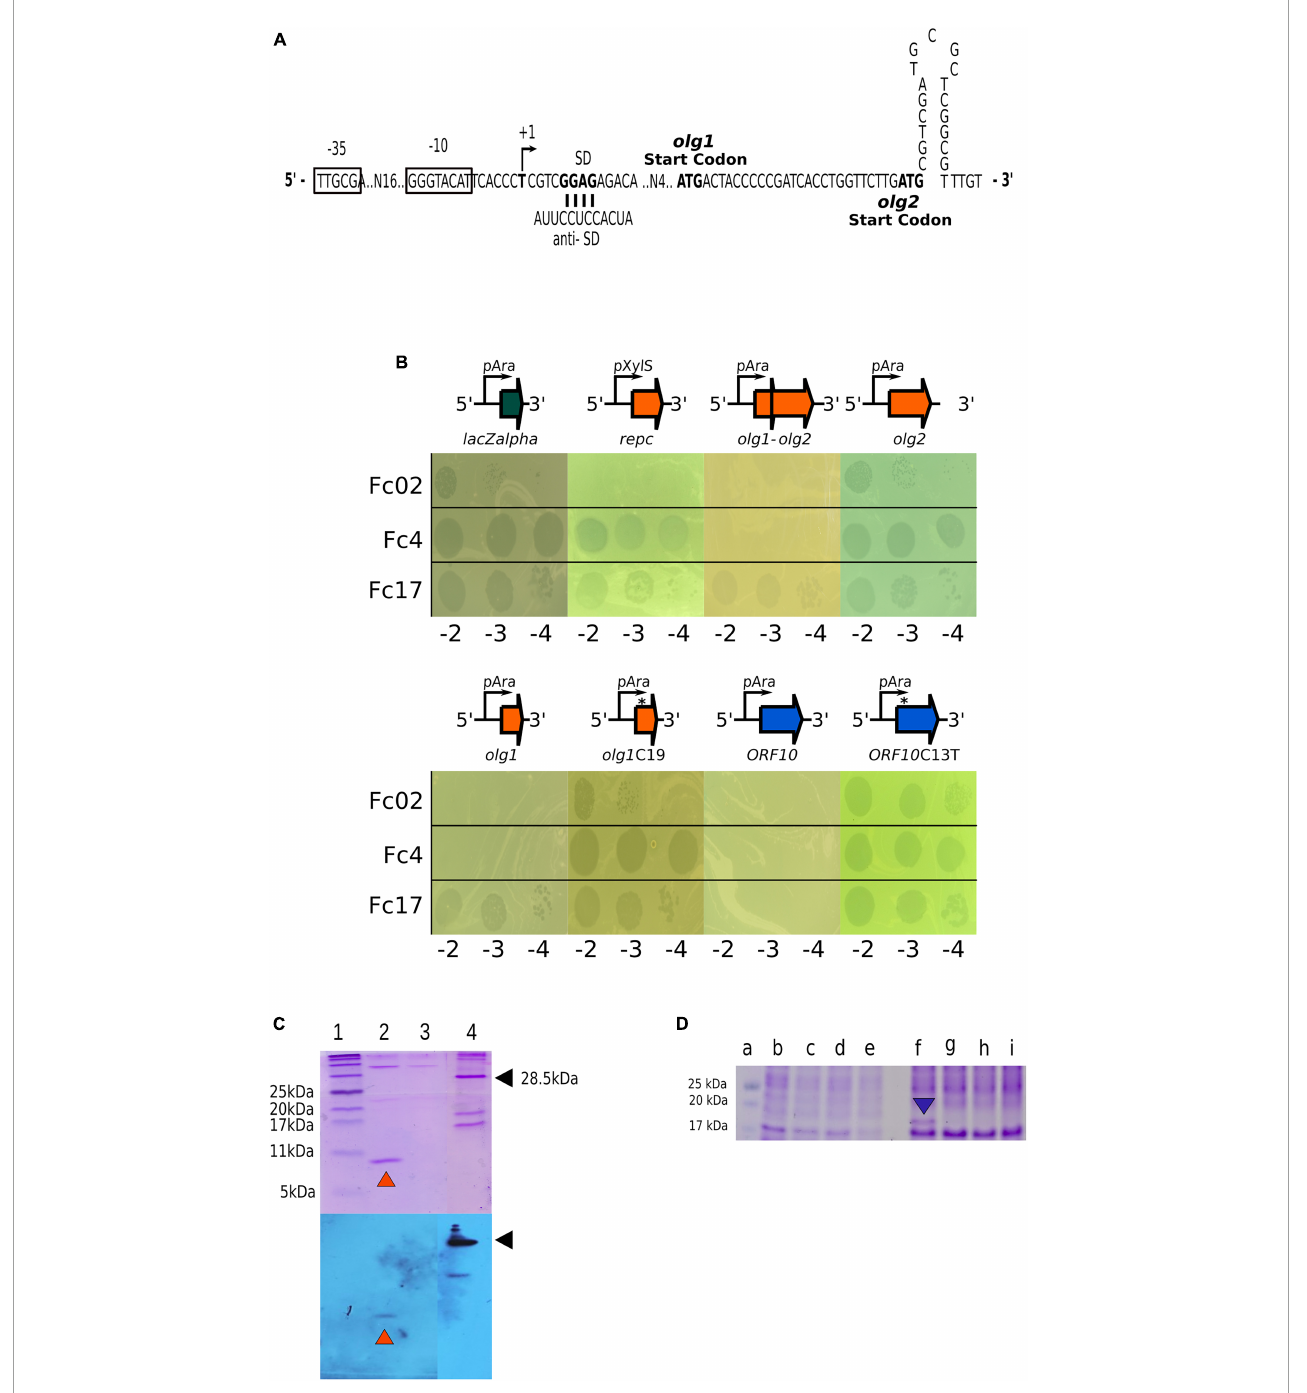
FIGURE5 Exclusion activity of Olg1 and ORF10. (A) Sequence detail of the overlapping genes promoter pC1 and nucleotide sequence between putative ATG start codons of olg1 and olg2 . A possible stem-loop terminator structure right after olg 2 start is shown. (B) Olg1 and ORF10 exclude other infecting phages. Drop assays were carried out with the indicated phage dilutions on induced (arabinose 0.3%) lawns of PAO1 harboring different pHERD30T-based constructs: p lacZalpha , empty vector; p repc , with phage Fc02 immunity repressor gene; pH olg1 - olg2 , with olg genes in the phage configuration; pH olg1 , with olg 1 only; pH olg1 C19 with mutant olg 1 with a cytosine insertion at position 19; pH olg2 , with olg 2 moved within a consensus distance from the vector SD sequence; pH ORF10 , with gene 10 of the reverse DNA strand; and orf 10C13T that creates a stop codon. (C) Protein Olg1 expression from a olg1- 6His construct in PAO1. Samples were analyzed by Tris-Tricine-SDS-PAGE (16%) followed by Coomassie blue staining (upper panel) or Western immunoblot probed with anti-His antibody (lower panel). Lane 1, BlueRay Prestained Protein Marker (Jena Bioscience); lane 2, Purified Olg1 protein after 3 h L-arabinose (0.3%) induction and Ni 2 + -affinity chromatography, indicated with orange arrowheads; lane 3, Olg1 construct without induction after Ni 2 + -affinity chromatography. Lane 4, a His-tagged protein control, indicated with black arrowheads. (D) Expression of ORF 10 variants in PAO1 from wild type and mutant constructs. Samples from overnight cultures induced for ORF10 expression with arabinose were analyzed through Tris-Glicine-SDS-PAGE (16%) followed by Coomassie blue staining. Lane a: Prestained Protein Ladder (MaestroGen AccuRuler RGBPlus); lanes b, c, d and e: soluble fractions; and lanes f, g, h, and i: solubilized pellet fractions. Lanes b and f: pHORF10; lanes c and g: pH ORF10 C13T; lanes d and h: pH ORF10C 25T; lanes e and i: pHERD30T empty vector. The blue arrowhead indicates the ORF10 protein